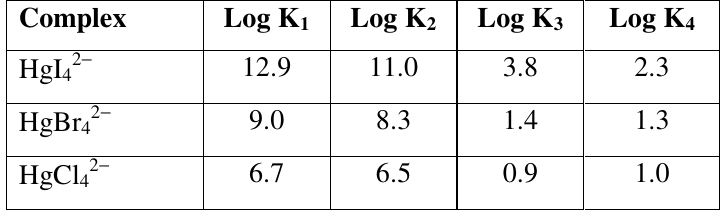
Table 1. Stability Constants of Mercury Halide Complexes.